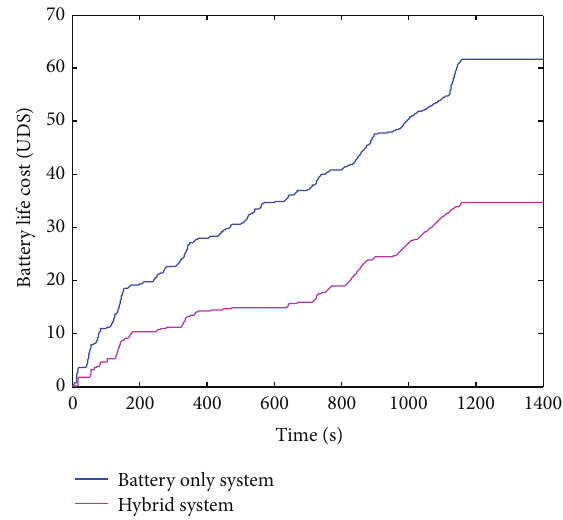
Figure 40: Comparison of the battery life cost based on NEDC driving